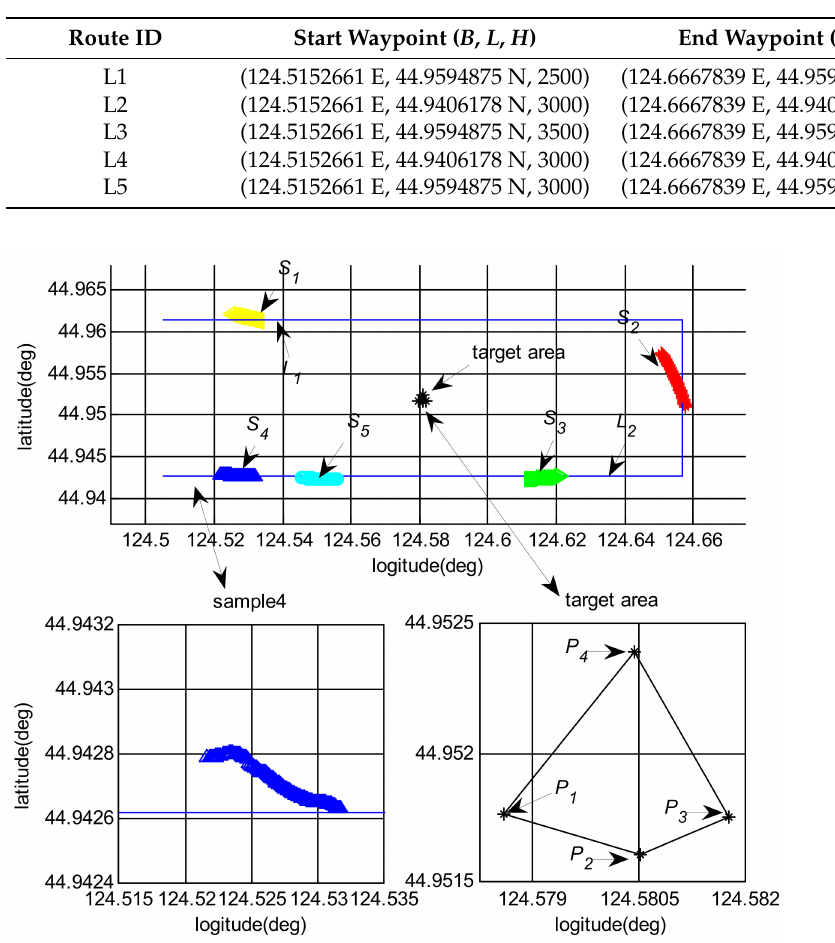
Table 4. Position of flight routes.